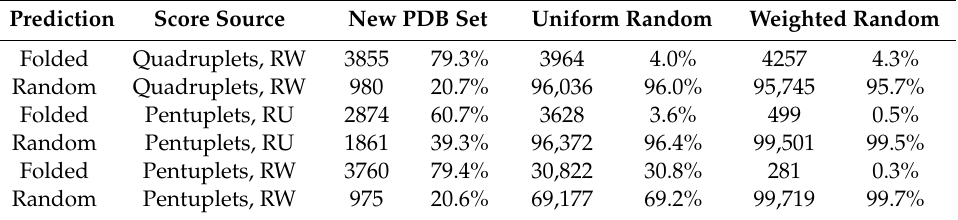
Table 1. Comparison of the foldability predictions using the quadruplet and pentuplet